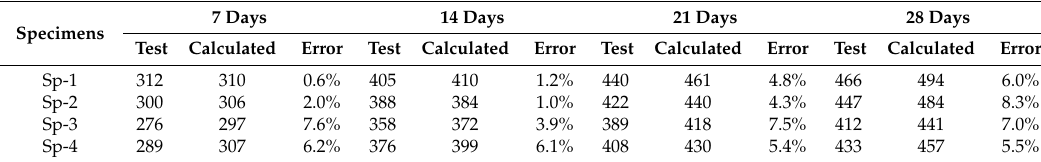
Figure 7. Comparison between the experimental results and those calculated using Equation (11). Table 6. Comparing of test value and calculated value ( µε ).